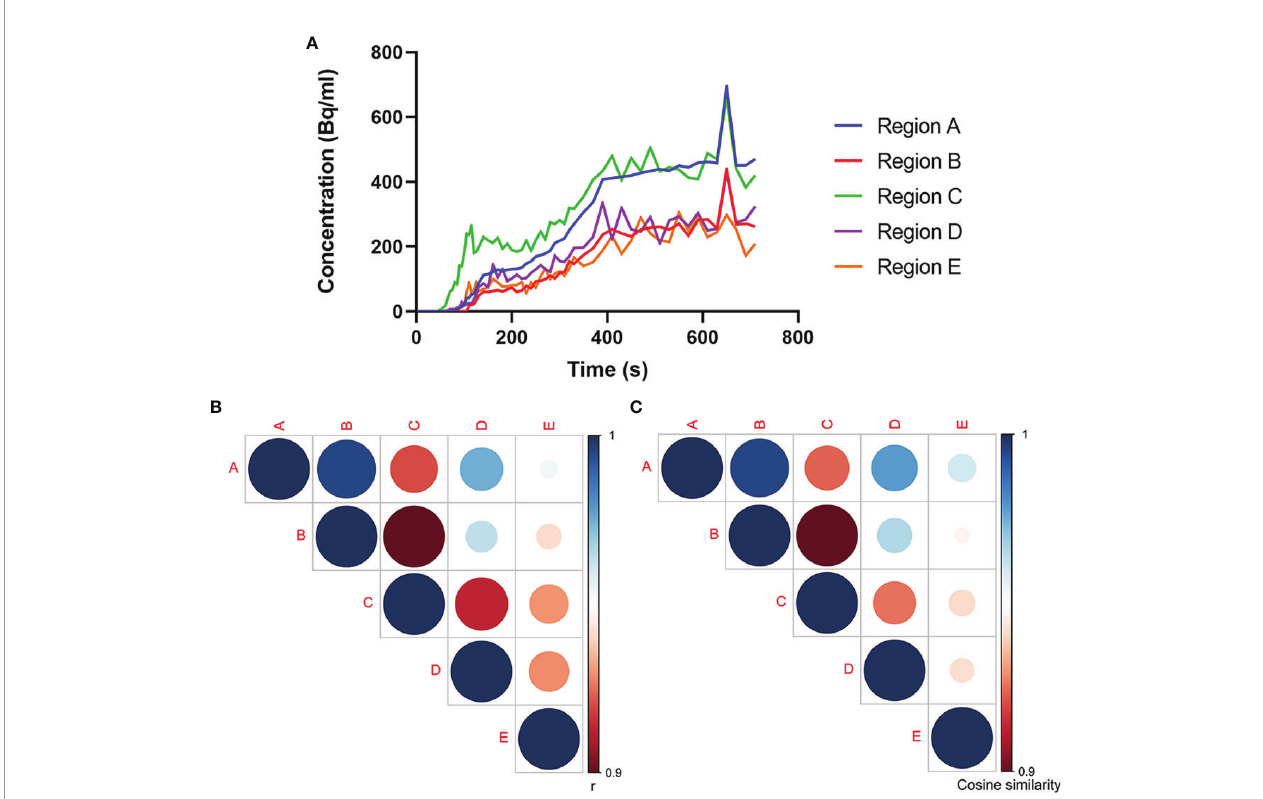
FIGURE 3 | Association analysis of 18F-FDG uptake in multiple regions. (A) Time – activity curves of 18F-FDG uptake at different sites. Analyses of (B) Pearson ’ s correlation coef fi cient and (C) cosine similarity index for time – activity curves between every two regions. The association between Regions A and B experiences highest Pearson ’ s correlation coef fi cient and cosine similarity index among the associations between every two regions, which con fi rms our speculation that Region B is the possible primary tumor site for Region A.